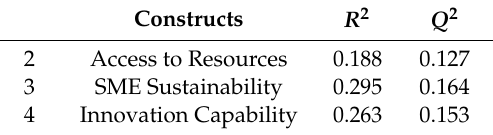
Table 5. Coefficient of determination ( R 2 ) and predictive relevance ( Q 2 ). Table 5. Coe ffi cient of determination ( R 2 ) and predictive relevance ( Q 2